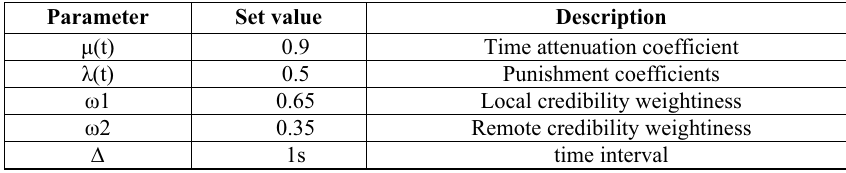
Table 1. Application parameters test results of different